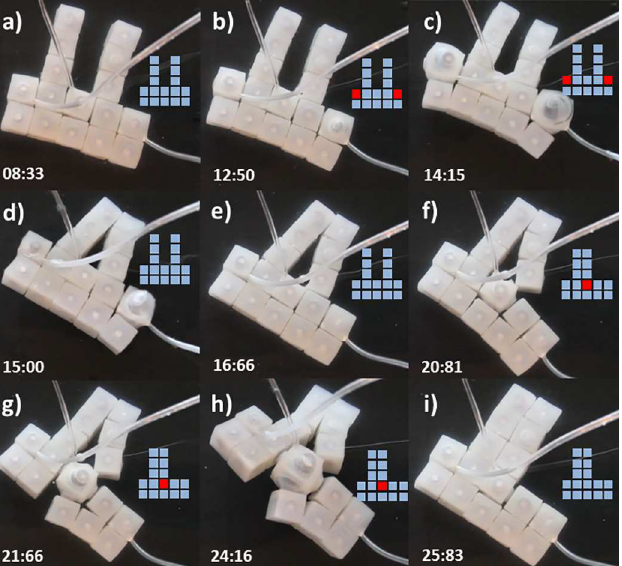
Fig 12. Self-Reconfiguration on setup 3A-13U. Demonstrationof self-reconfiguration on a group of 16 modulessubmerged in water. The two lateral modulesare first inflated (b) resultingin the closureof the ‘C’. Lateral modulesare then deactivated(d). Next the upper-centermodule activates (f) and deactivates(i) resulting in the new stable ‘T’ shape.Timestamps are in the format